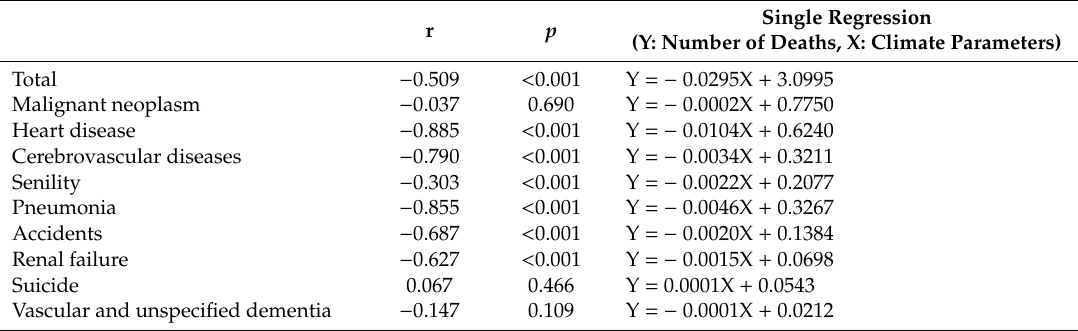
Table 4. Simple correlation analysis of number of deaths ( / one hundred thousand people / day) and mean air temperature in Gifu prefecture,